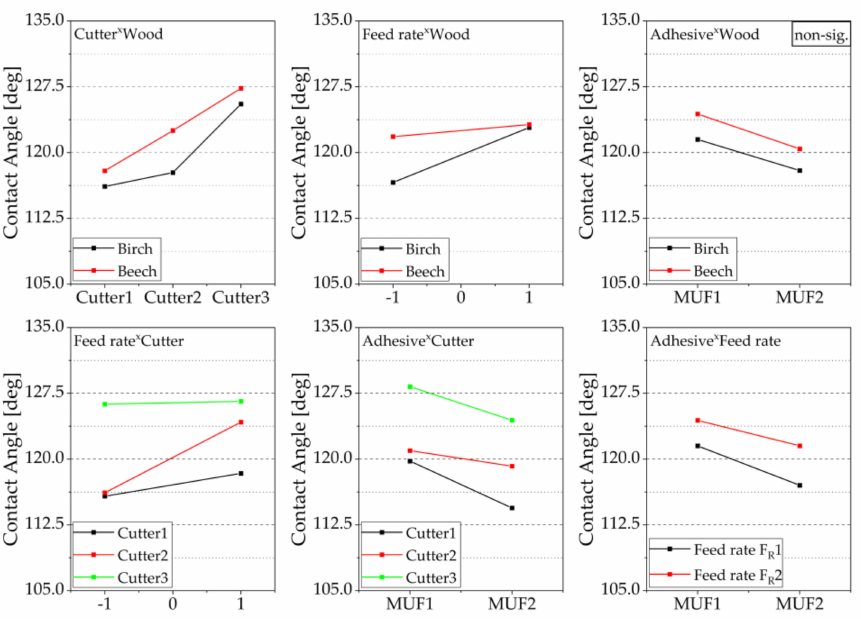
Figure 9. 2-way interactions of the contact angle for different cutting combinations, mean values of the factors are shown, interactions are visualized based on the courses of the effect lines; please see explanatory Figure